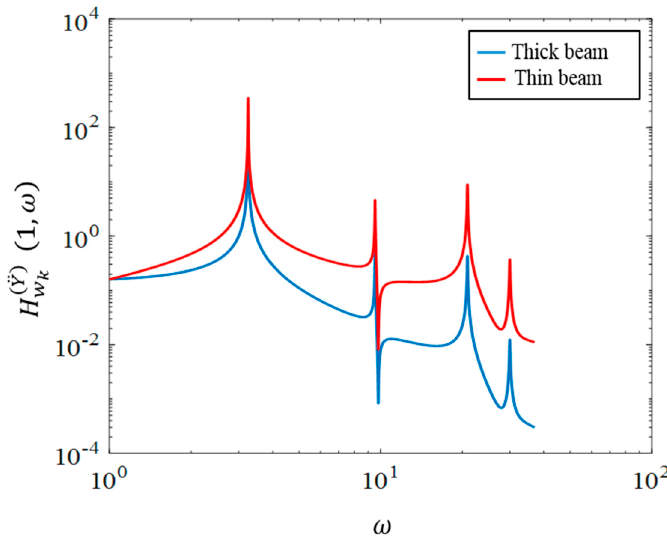
Figure 6. Frequency response curves of the normalized tip displacement of the thin and thick beams due to harmonic base acceleration.